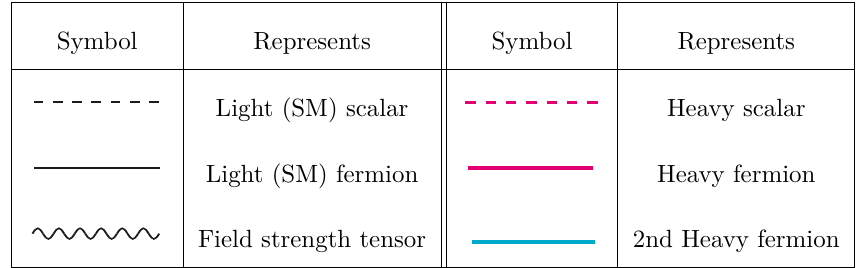
Table 1. Representations for tree-level light and heavy propagators of various spins.